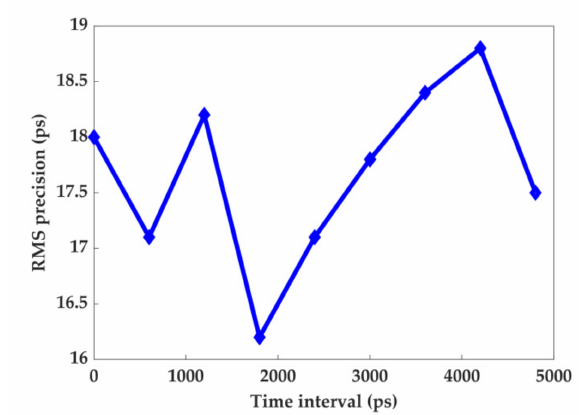
Figure 11. RMS precision of difference time intervals.